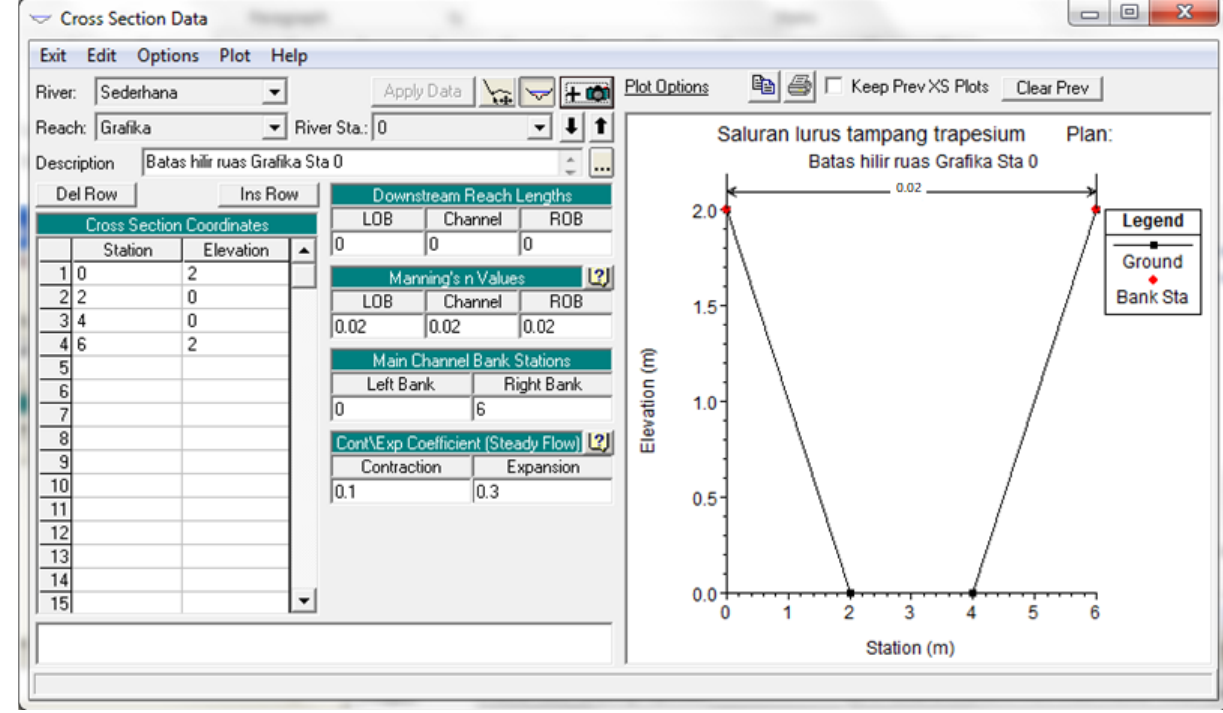
Figure 6. Cross section on the river.